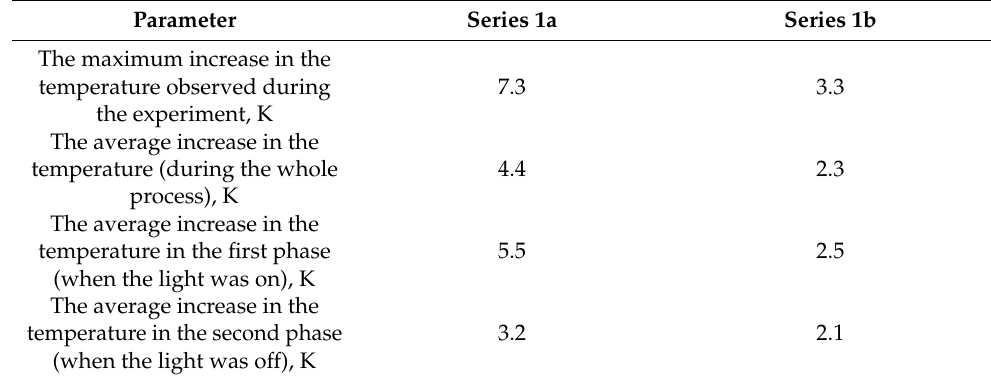
Figure 6. The increase in the temperature of the ventilation air when the SAH operated as a solar chimney (Series 1a) and a solar thermal wall (Series 1b). Table 4. Summarization of the increase in the temperature of the ventilation air when the SAH operated as a solar chimney (Series 1a) and a solar thermal wall (Series 1b).